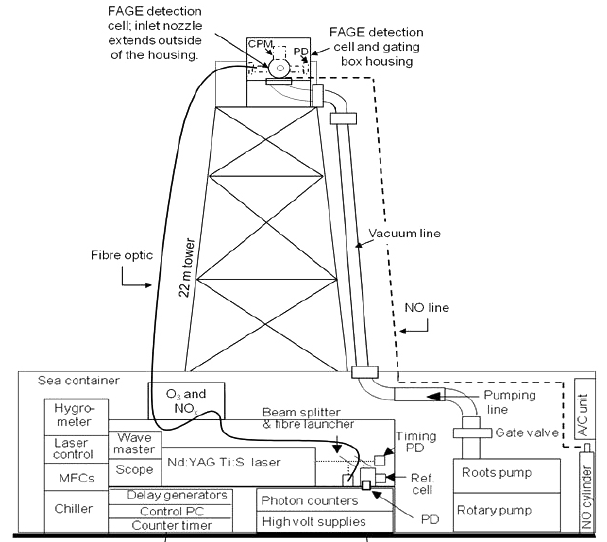
Figure 1. Schematic of the FAGE instrument set-up during the HCCT-2010 campaign. “PD” refers to photodiode, used to nor- malise the observed HO 2 signal to laser